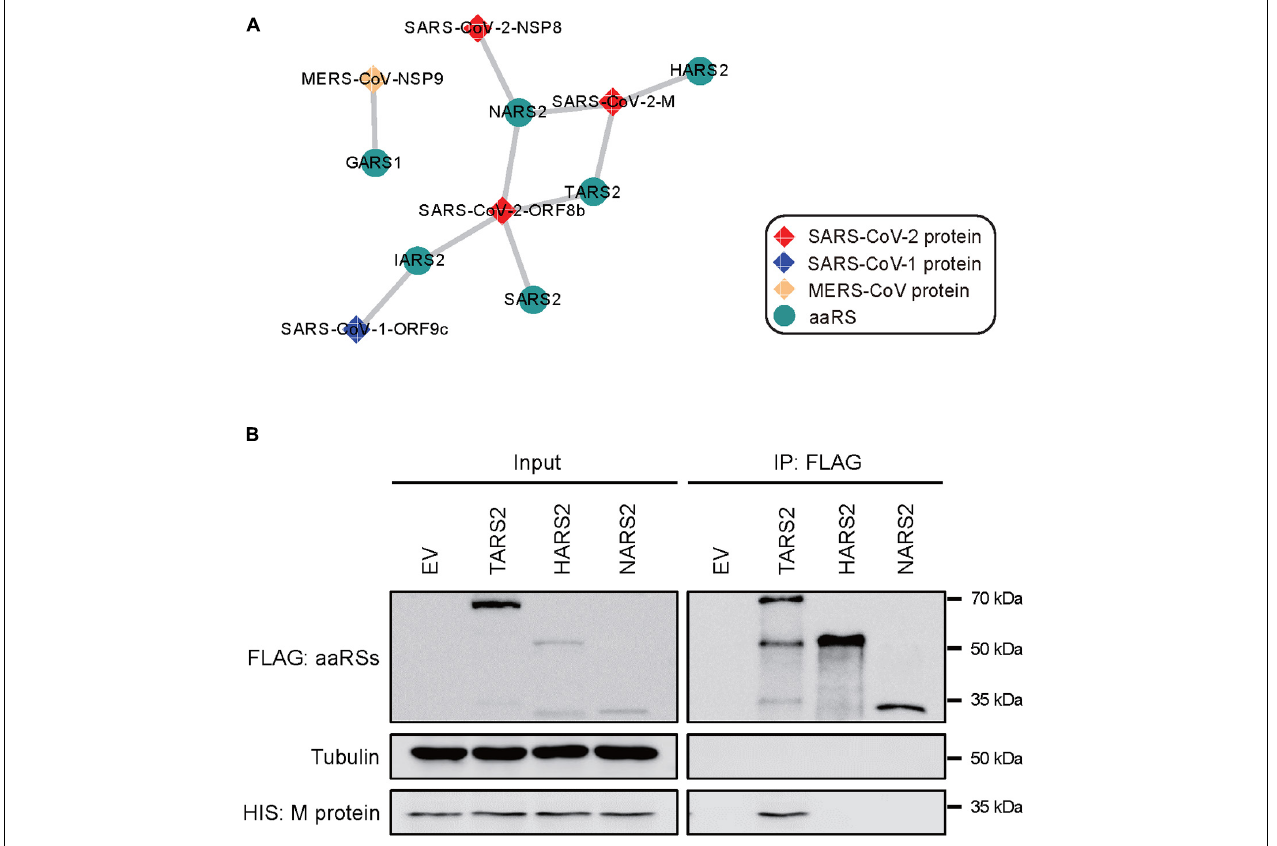
FIGURE 4 | Interaction networks between CoV-proteins and human aminoacyl-tRNA synthetases (aaRSs). (A) Physical interactions of CoV-proteins with human aaRSs. Viral proteins are shown as diamonds and the interacting aaRSs are shown as circles. (B) Interaction of SARS-CoV-2 M protein with TARS2, HARS2, and NARS2 in human HEK293T cells using co-immunoprecipitation (co-IP) assays. An empty vector (EV) was used as a negative